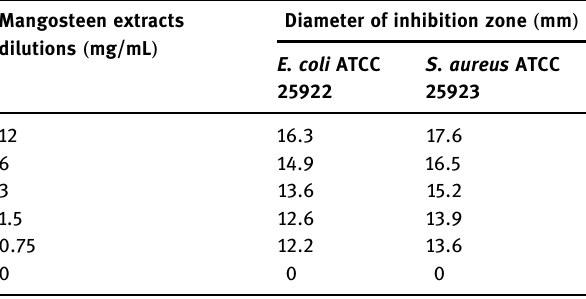
Table 2: Antimicrobial e ff ect of MPE on the tested organisms Mangosteen extracts